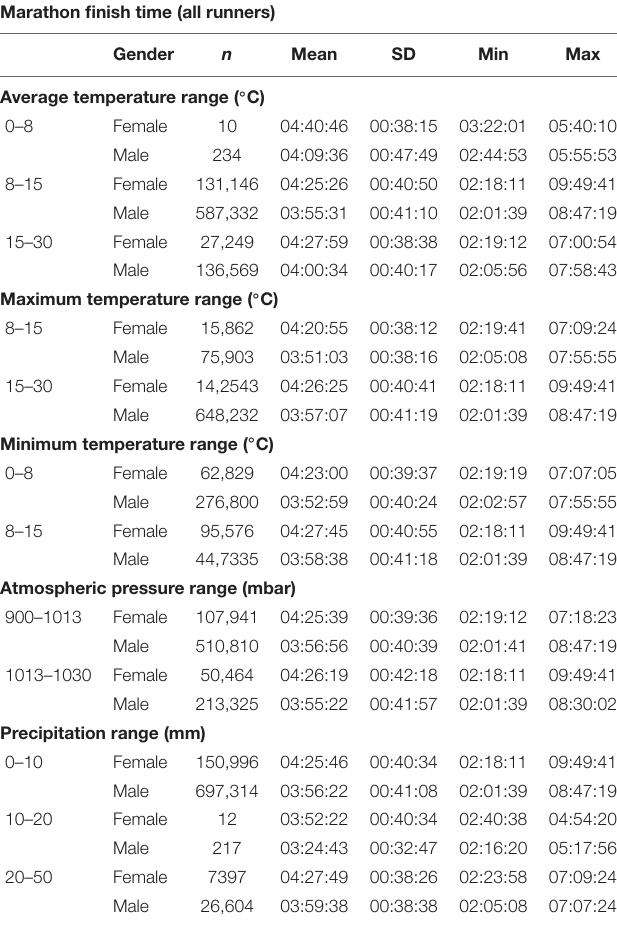
TABLE 2 | All runners marathon finishing times in relation to ambient conditions; mm (millimeter), mbar (millibar), C (degrees Celsius), SD (standard